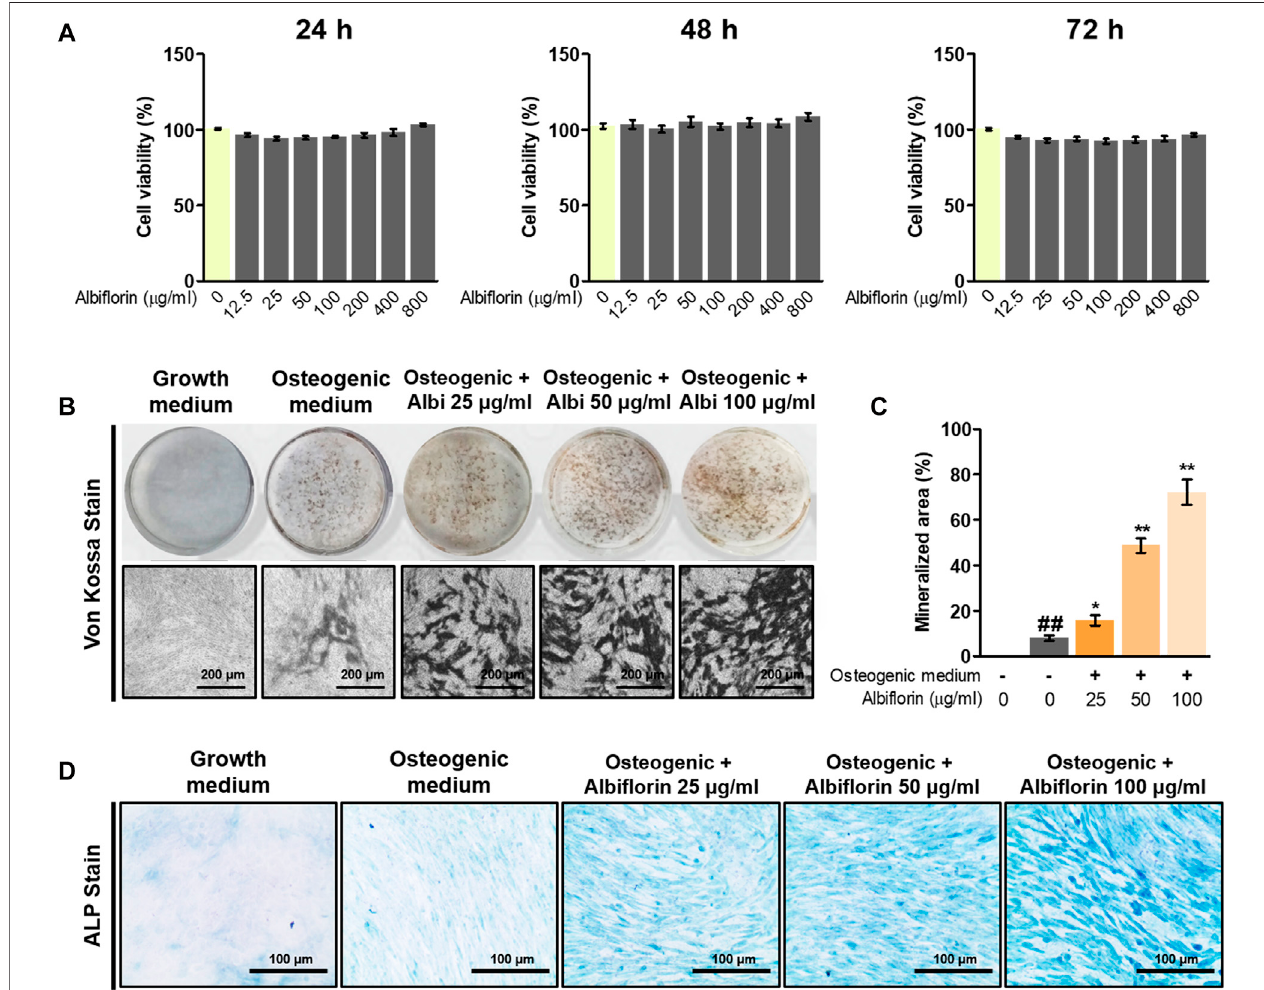
FIGURE 5 | Effect of albi fl orin on osteoblast differentiation and bone mineralization. (A) The toxicity of albi fl orin in MC3T3-E1 cells was determined using a CCK-8 assay. (B) Theeffectofalbi fl orinonmineralizednoduleformationwasanalyzedbyvonKossastainingusingacameraandmicroscope( × 100magni fi cation,200 μ m). (C) The mineralized area was measured using ImageJ software. (D) ALP expression in MC3T3-E1 cells was determined using an ALP Staining Kit ( × 200 magni fi cation, 100 μ m). These results are presented as the mean ± SEM ( n (cid:2) 3 for each experimental). ## p < 0.01 vs. growth medium cells; ** p < 0.01, * p < 0.05 vs. osteogenic medium